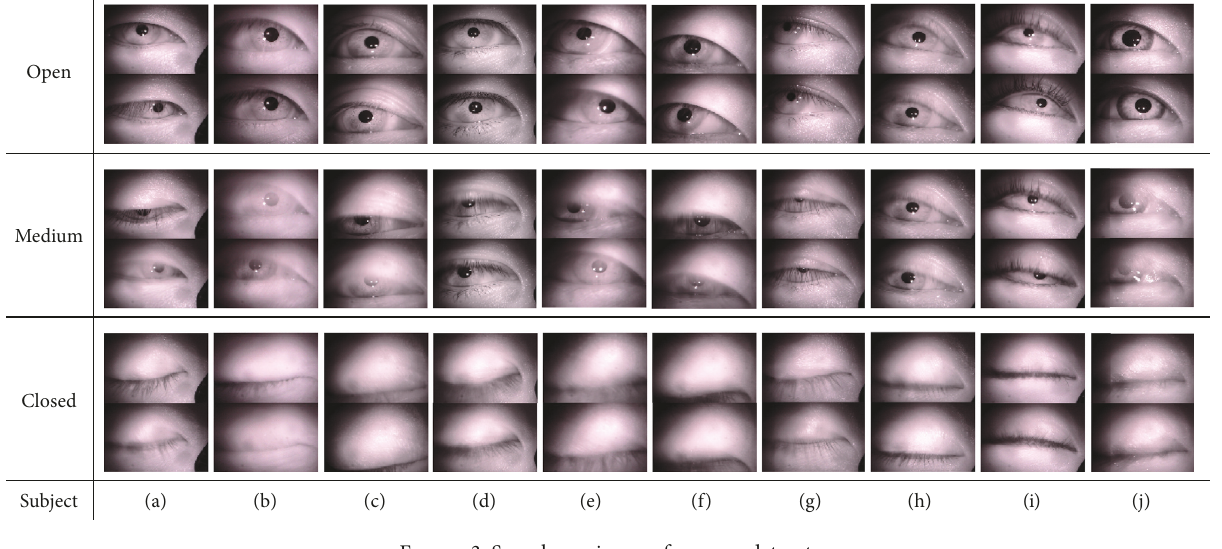
Figure 3: Sample eye images from our dataset.